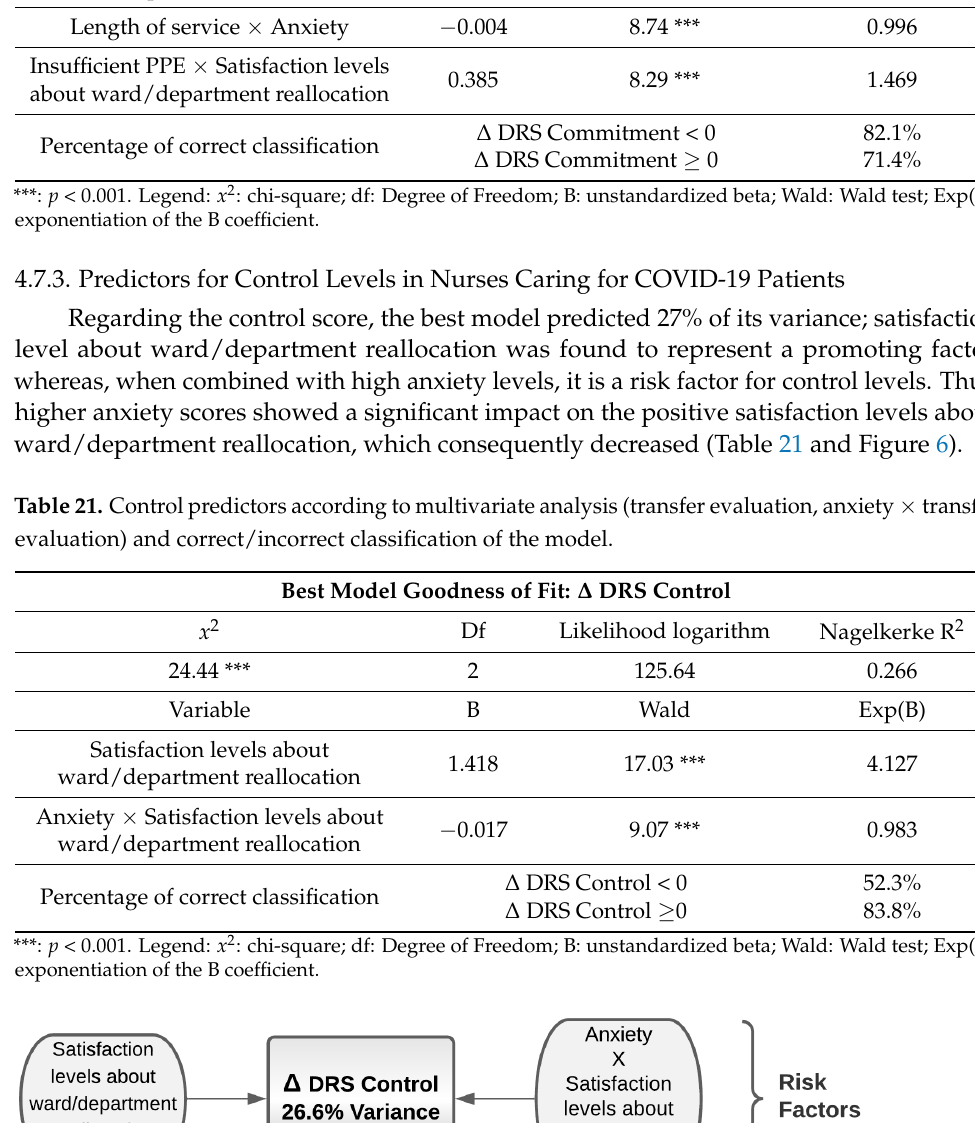
Table 21. Control predictors according to multivariate analysis (transfer evaluation, anxiety × transfer evaluation) and correct/incorrect classification of the model.